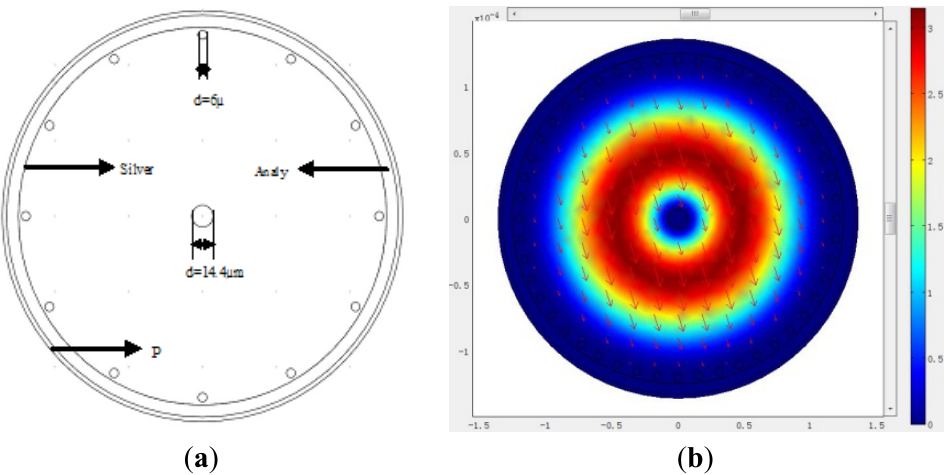
Figure 1. ( a ) Structure diagram of the large-mode-area plastic photonic crystal fiber; ( b ) Optical field distribution of the fundamental